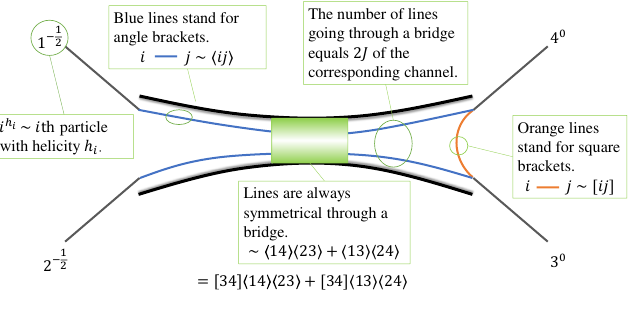
Figure 2 . Spinor bridge rules presented with a 2-partite example of a J = 1 amplitude [34] h 14 ih 23 i + [34] h 13 ih 24 i . The bridge rule of partial wave expansion includes 3 main aspects. (1) All particles are labeled and categorized into their respective channels, and each categorization is called a partition, e.g. { 12 | 34 } of this figure; (2) each thread connecting two particles stands for a bracket, orange for square brackets and blue for angle brackets, while the number of orange and blue threads ending at a particle is constrained by its helicity; (3) a bridge is built up by threads connecting two channels, and all the threads through a bridge should be of the same type (orange/blue) and totally